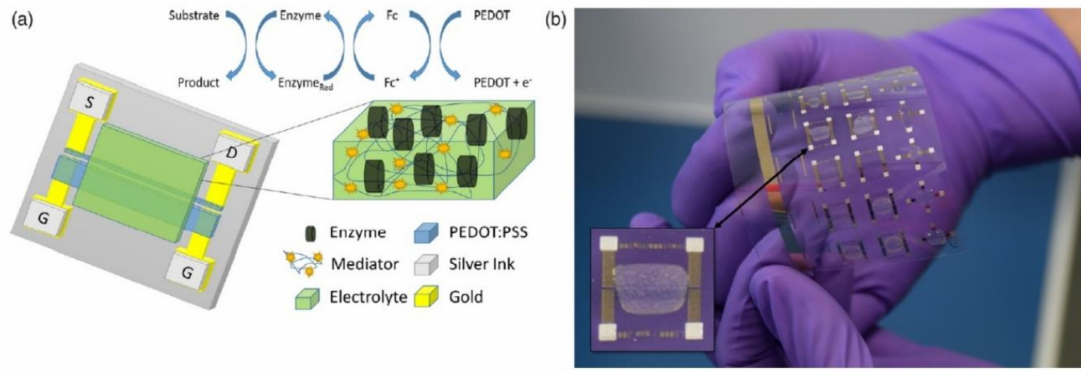
Figure 10. Screen-Printed Organic Electrochemical Transistors for metabolite sensing: ( a ) schematic representation of the OECT enzymatic sensor and the enzymatic reaction mechanism; and ( b ) photograph of the corresponding wafer with an OECT biosensor in inset. Reproduced with permission from [111]. © Materials Research Society